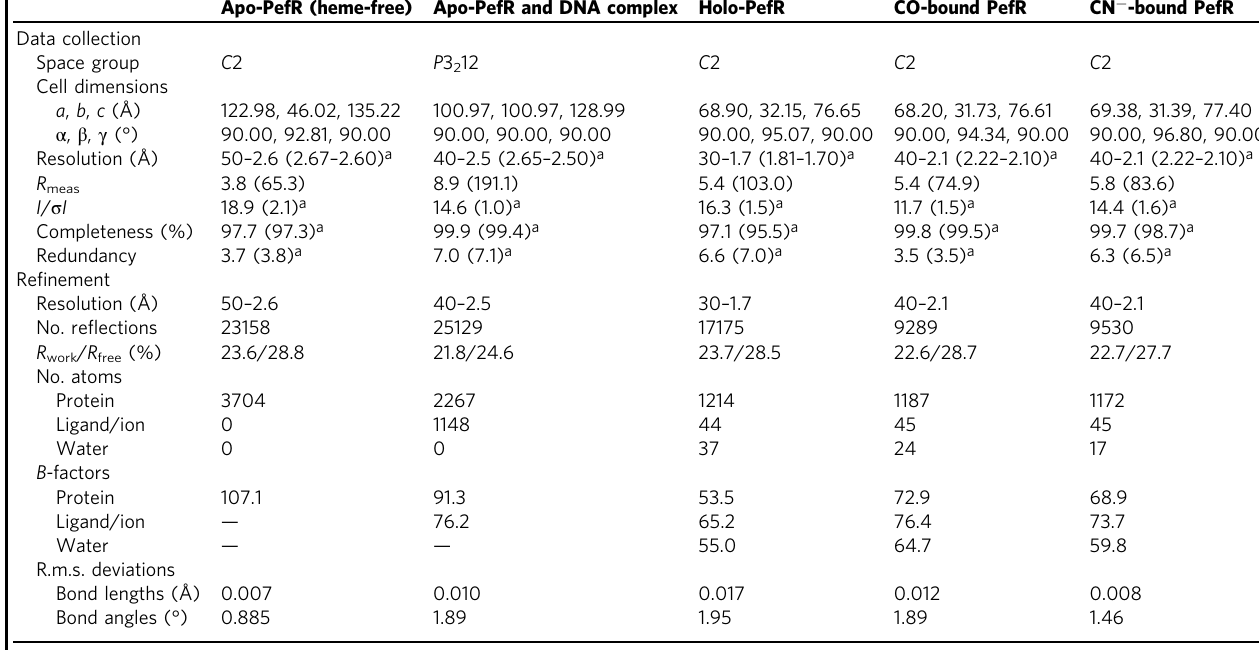
Table 1 Data collection and re fi nement statistics (molecular